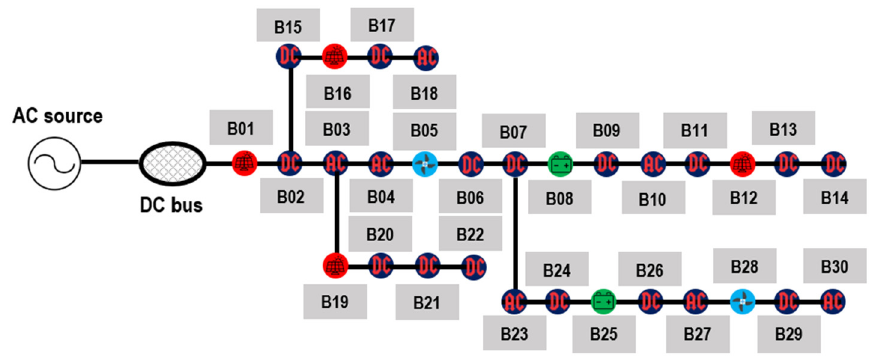
Figure 3. Diagram of an example 30-bus DC microgrid (Bxx denotes for the order of bus in the considered DC microgrid).